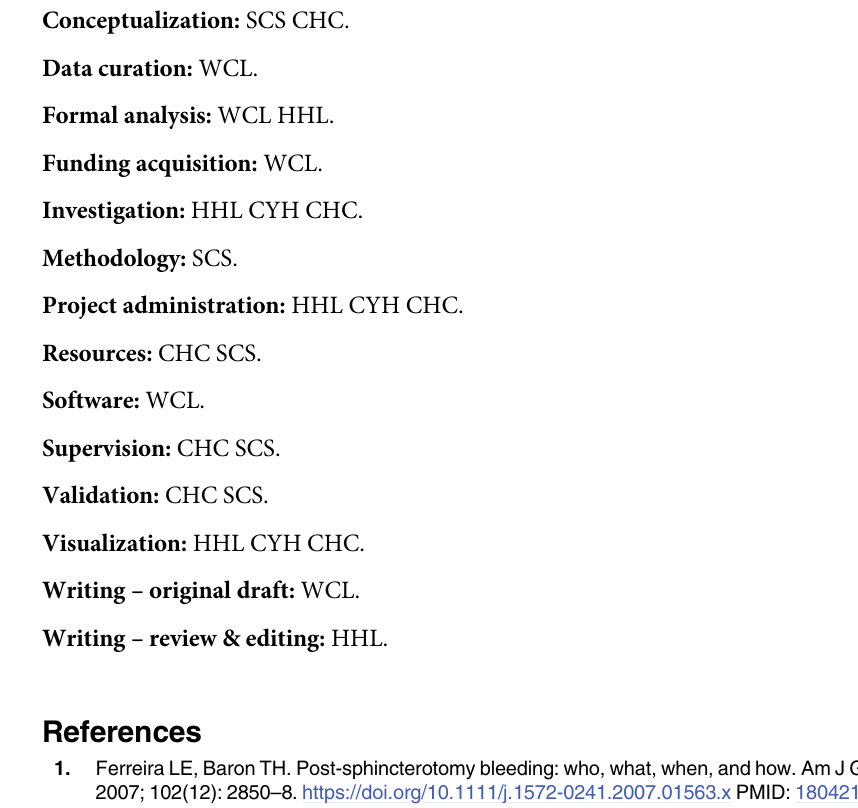
S1 Table. Clinical characteristics of patients in the immediate and delayed post-endoscopic sphincterotomy bleeding groups. S2 Table. Endoscopic features and therapy in the delayed post-endoscopic sphincterotomy